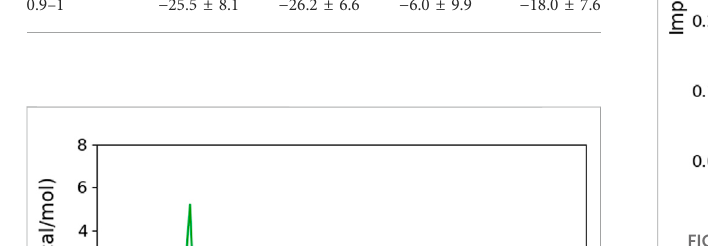
FIGURE 9 Per-proteinresidueimportancefromthePCAanalysis forthe different PCBP1 mutants in interaction with the ° GCCCUG ° G RNA sequences: WT (orange), K23Q (blue), K23M (green), and K31D